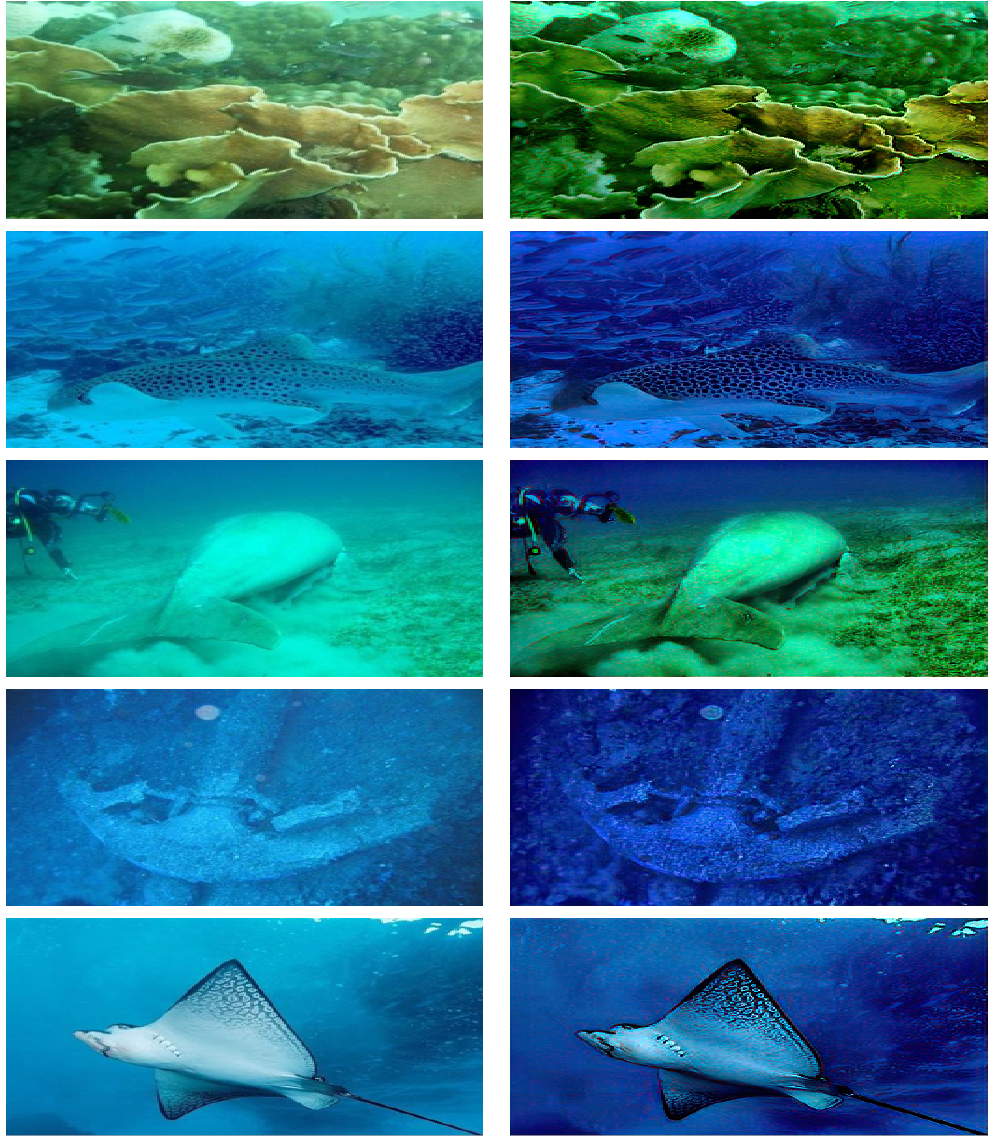
Figure 7. Comparison of coral reef, fish, whale, ship anchor and stingray images from the top row to the last row. From left to right are raw underwater images, and proposed images. These images are compared with the results from Fus [32], WCID [33], Ts [34], LD